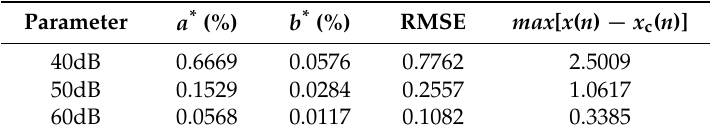
Table 4. Parameter identification and error of the noisy oblique envelope signals.